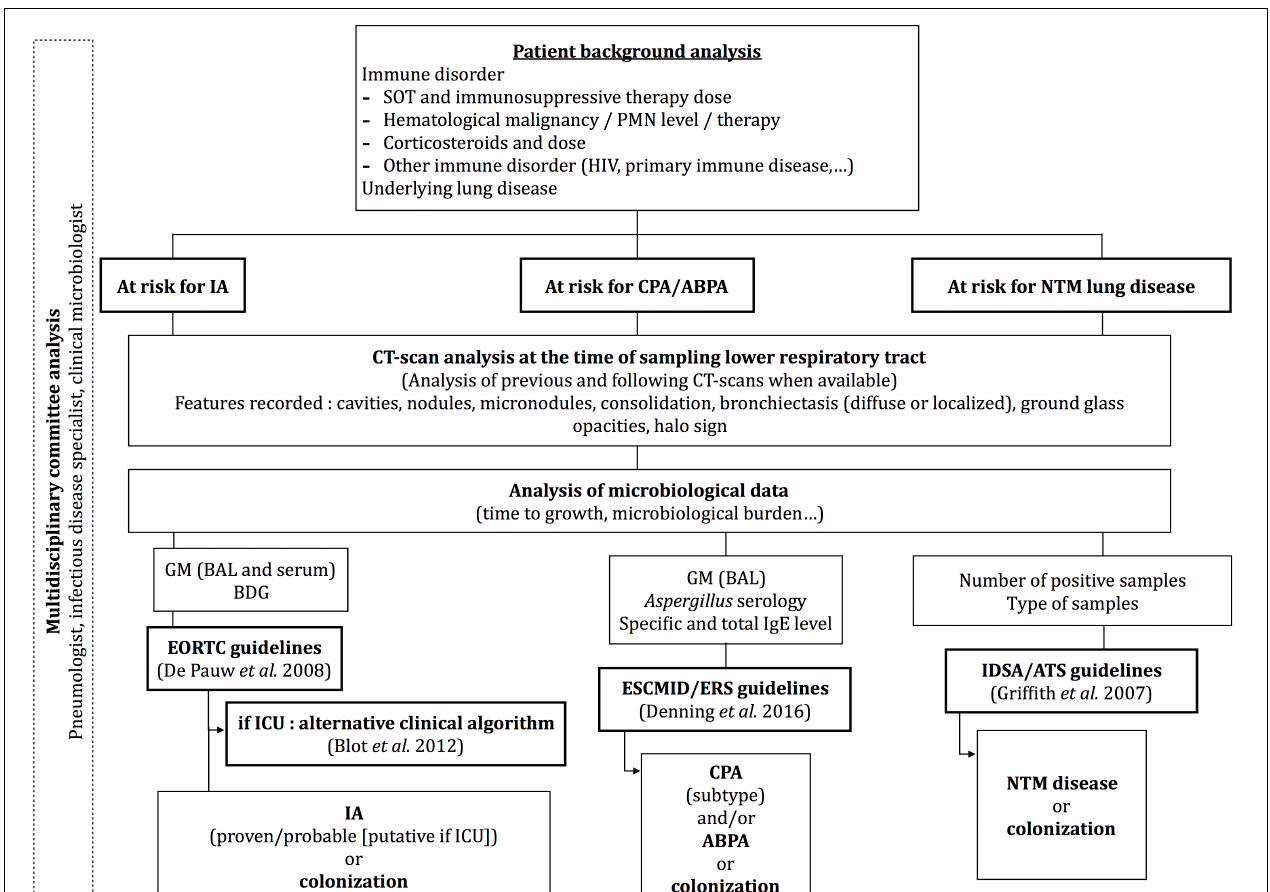
FIGURE 1 | Algorithm used by a multidisciplinary committee to classify patients as infected or colonized by Aspergillus or NTM. ABPA, allergic bronchopulmonary aspergillosis; BDG, ß-1,3-glucan; CPA, chronic pulmonary aspergillosis; GM, galactomannane; IA, invasive aspergillosis; NTM, non-tuberculous mycobacteria; PMN, polymorphonuclear; SOT, solid organ